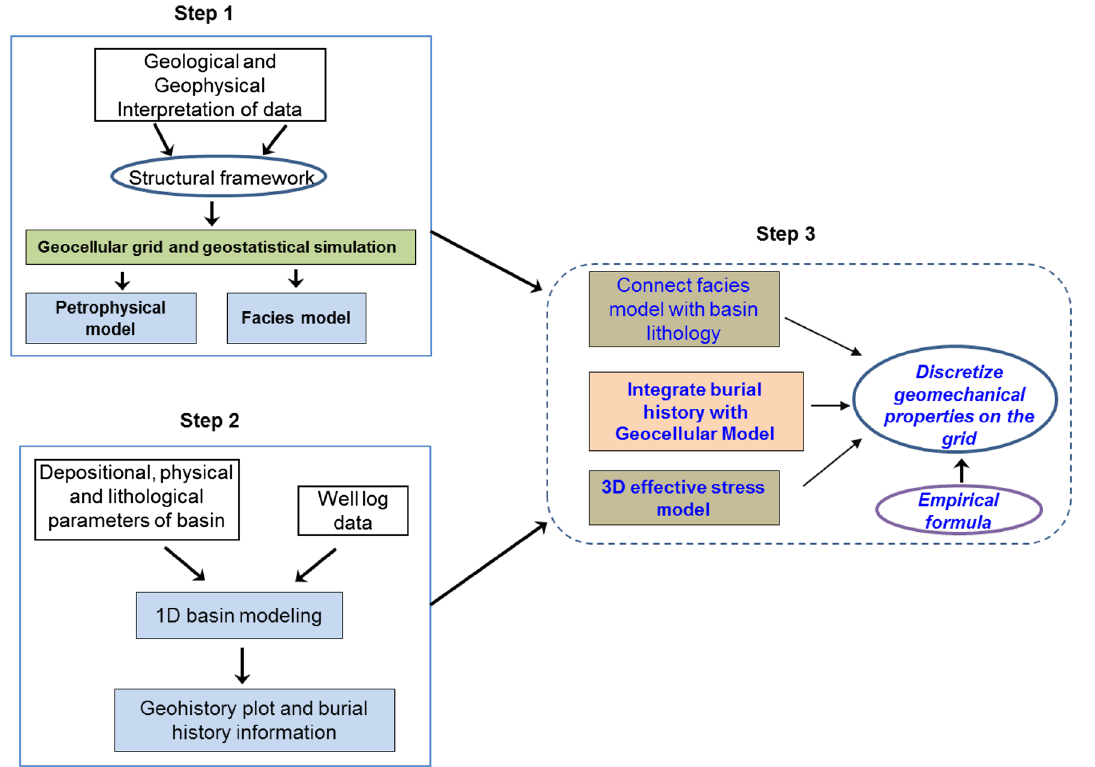
Fig. 1 Diagrammatic representation of geocellular model and basin model integration